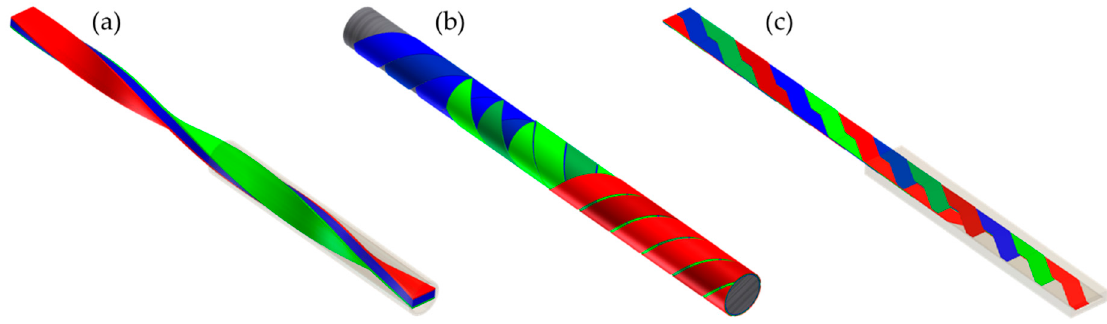
Figure 5. Schematic illustration of different REBCO-based cables: a twisted stacked tape cable [22] ( a ), a Conductor on Round Core (CORC ) [25] ( b ), and a Roebel Cable [26] ( c ). Adapted from Ref. [28].